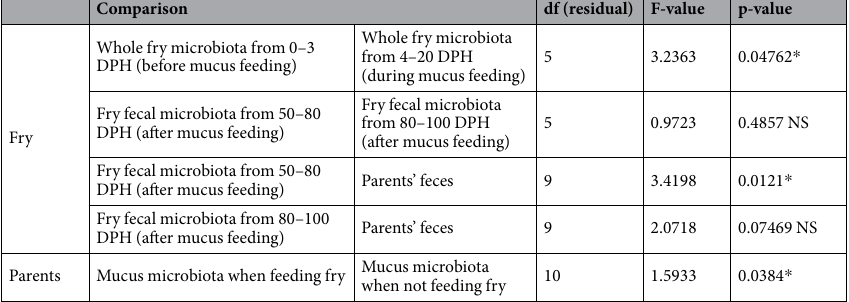
Table 2. PERMANOVAs highlight maturation of the fry fecal microbiota before 80–100 DPH. Results of the PERMANOVAs (10,000 permutations) comparing the microbial communities of the whole fry or fry fecal microbiota from different life stages with the one in their parents’ feces. Comparisons were only made between similar types of biological samples: whole fry samples compared to whole fry samples, feces samples compared to feces samples, and skin mucus samples compared to skin mucus samples. PERMANOVAs were performed with package vegan on R. “df” stands for “degrees of